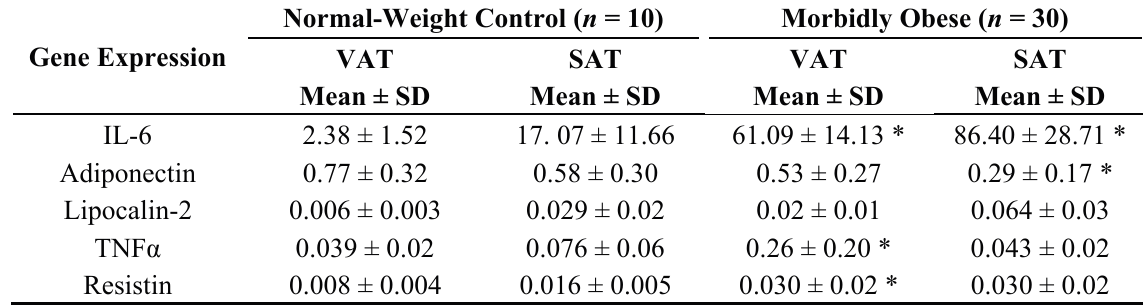
Table 2. Adipo/cytokines gene expression in morbidly obese patients and normal-weight subjects. VAT, visceral adipose tissue; SAT, subcutaneous adipose tissue. Normal-Weight Control ( n = 10) Morbidly Obese ( n = 30) Gene Expression VAT SAT